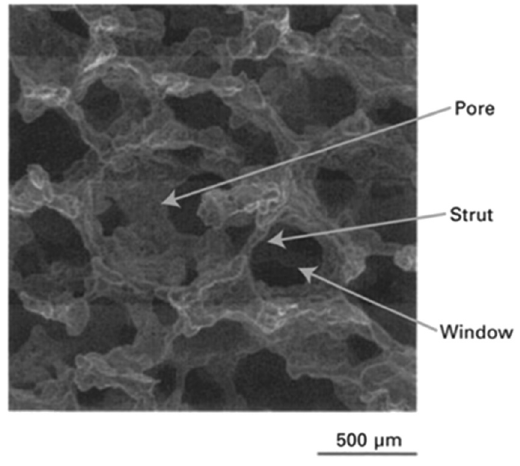
Figure 11: Closed - cell structured porous aluminium foam obtained via space holder method [ 120 ]